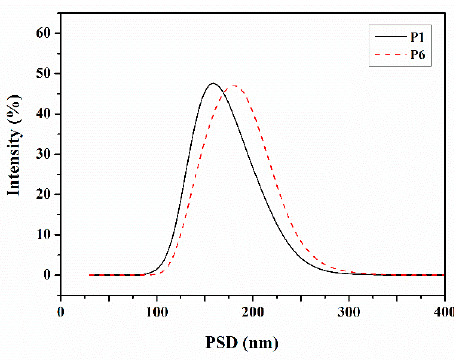
Figure 4. Comparison of the PSD in the laboratory-scale ( P1 ) and industrial-scale experiments ( P6 ).